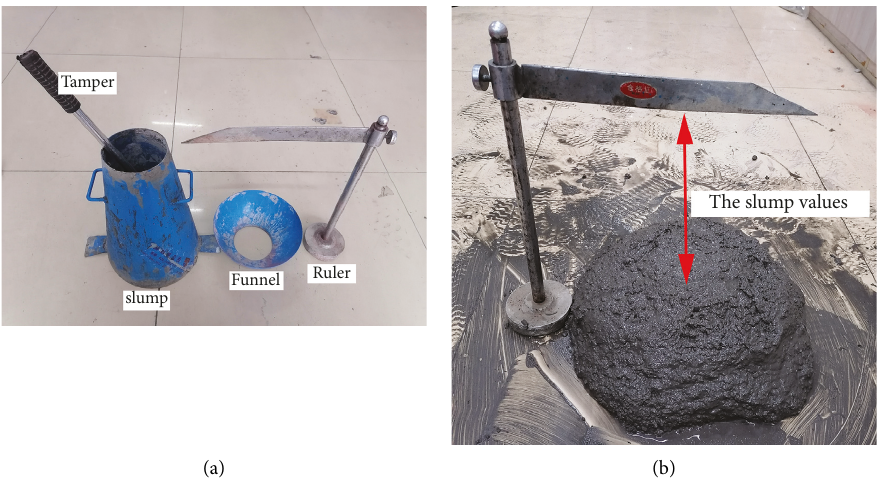
Figure 5: Photos of slumps test. (a) Measuring device. (b) Slump measurement.